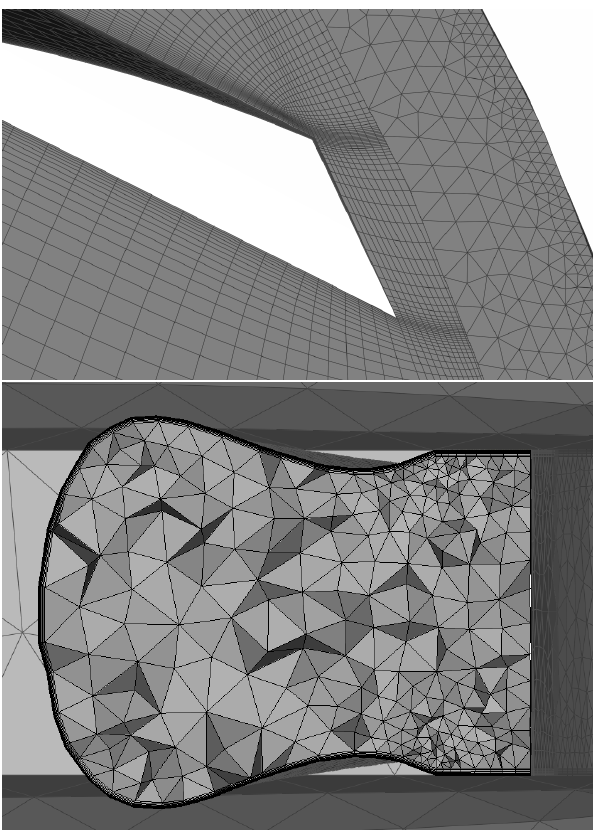
Figure 10. Detail of the impeller ( top ) and volute ( bottom ) mesh for the baseline design, medium mesh.